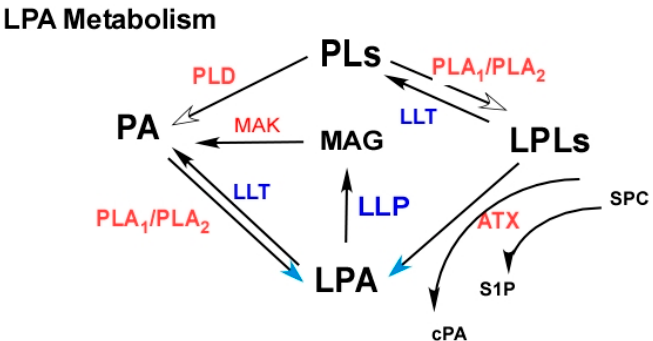
Figure 2. LPA metabolism as potential targets. Phospholipids (PLs), phosphatidic acid (PA), lysophospholipids (LPLs). The enzymes in red color, autotaxin (ATX), phospholipase A 1 (PLA 2 ), phospholipase D (PLD), and monoacylglycerol kinase (MAK), need to be inhibited to reduced LPA. ATX inhibitors are currently in clinical trials. The enzymes in blue, lipid phosphate phosphatase enzymes (LPPs), lysophospholipase transacylase (LLPT), or LPA acyltransferase (LPAT), need to be enhanced to increased LPA degradation. However, these enzymes are also involved in the metabolism of other lipid molecules, and the overall outcome may be complex. ATX may have multiple functions. It also produces sphingosine-1 phosphate (S1P) from sphingosylphosphorylcholine (SPC) and cyclic phosphatidic acids from lysophospholipids (LPLs). Cyclic PAs (cPAs) have anti-tumor activities [176] .